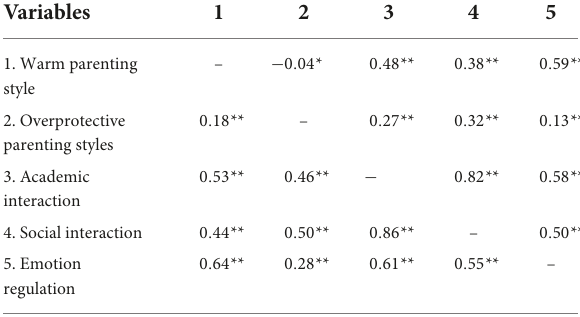
TABLE 3 Correlation analysis of variables in different gender